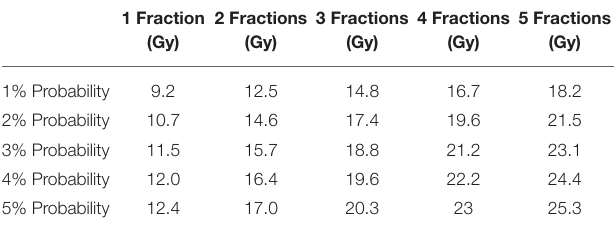
TABLE 7 | Predicted maximal dose for 1–5 fractions that results in 1–5% probability of radiation myelopathy after radiosurgical